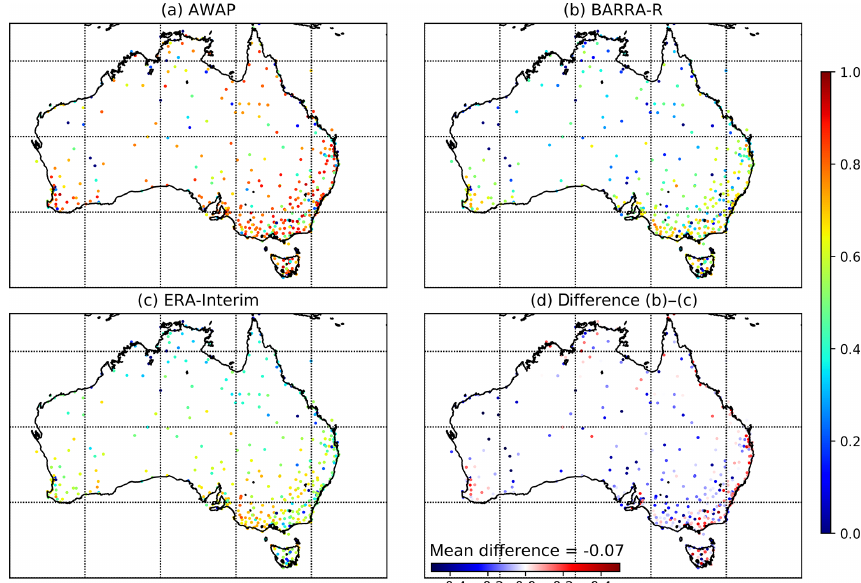
Figure 2. Modified Kling–Gupta efficiency (KGE (cid:48) ) against gauge dataset at daily scale for (a) AWAP, (b) BARRA, and (c) ERA-Interim, and (d) difference of KGE (cid:48) between BARRA and